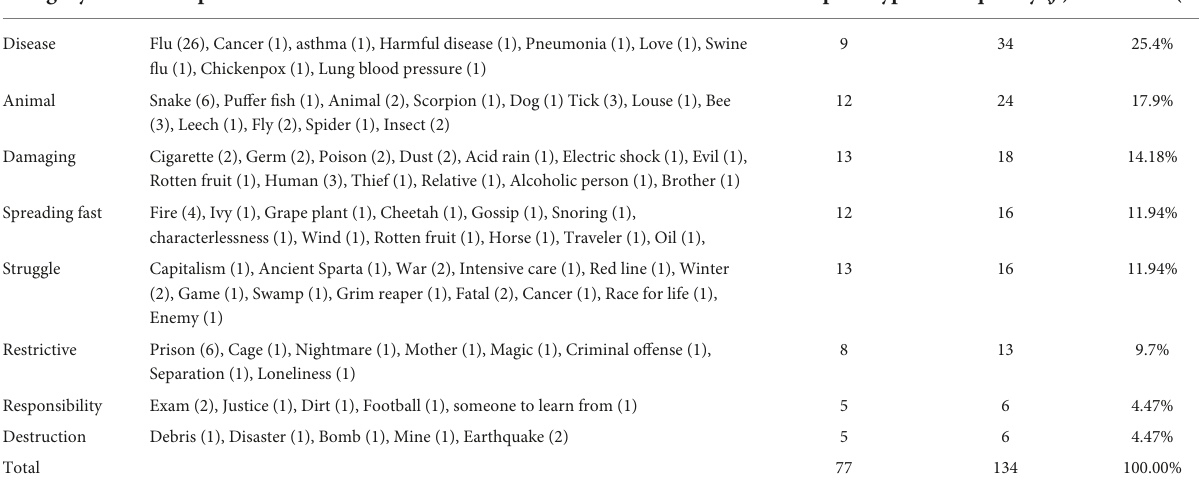
TABLE 3 Categories of metaphors related to the concept of “COVID-19” created by high school students. Category